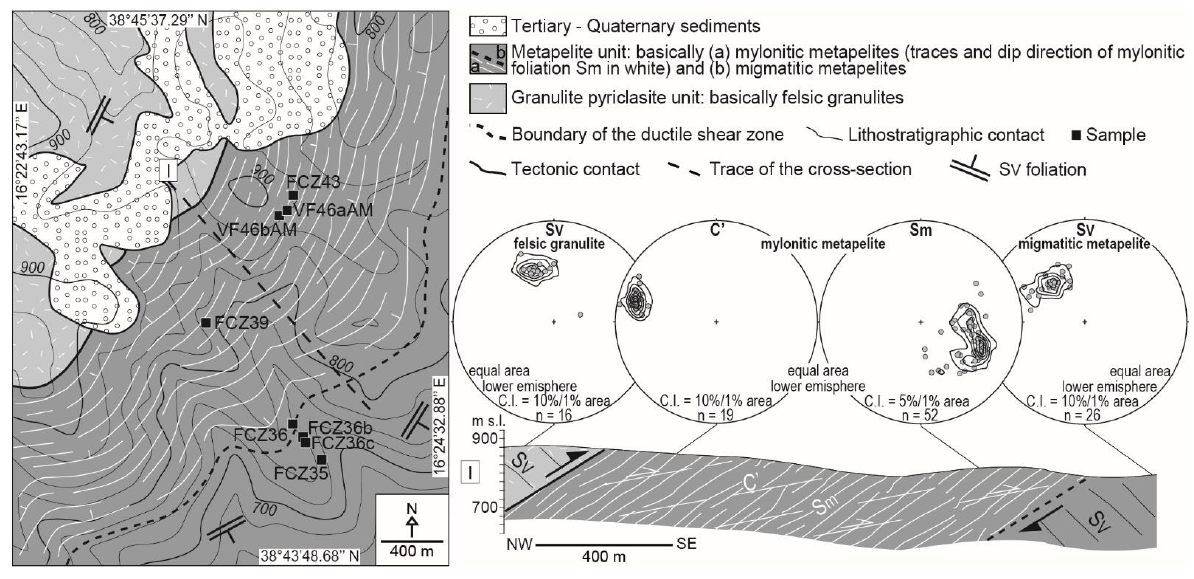
Figure 2. Structural sketch map of the Serre dei Meriani – Passo Fosso del Lupo area (see Figure 1 for location) and geological cross section with stereographic projections (poles) of the S V and S m and C ’ mylonitic foliations, on top.